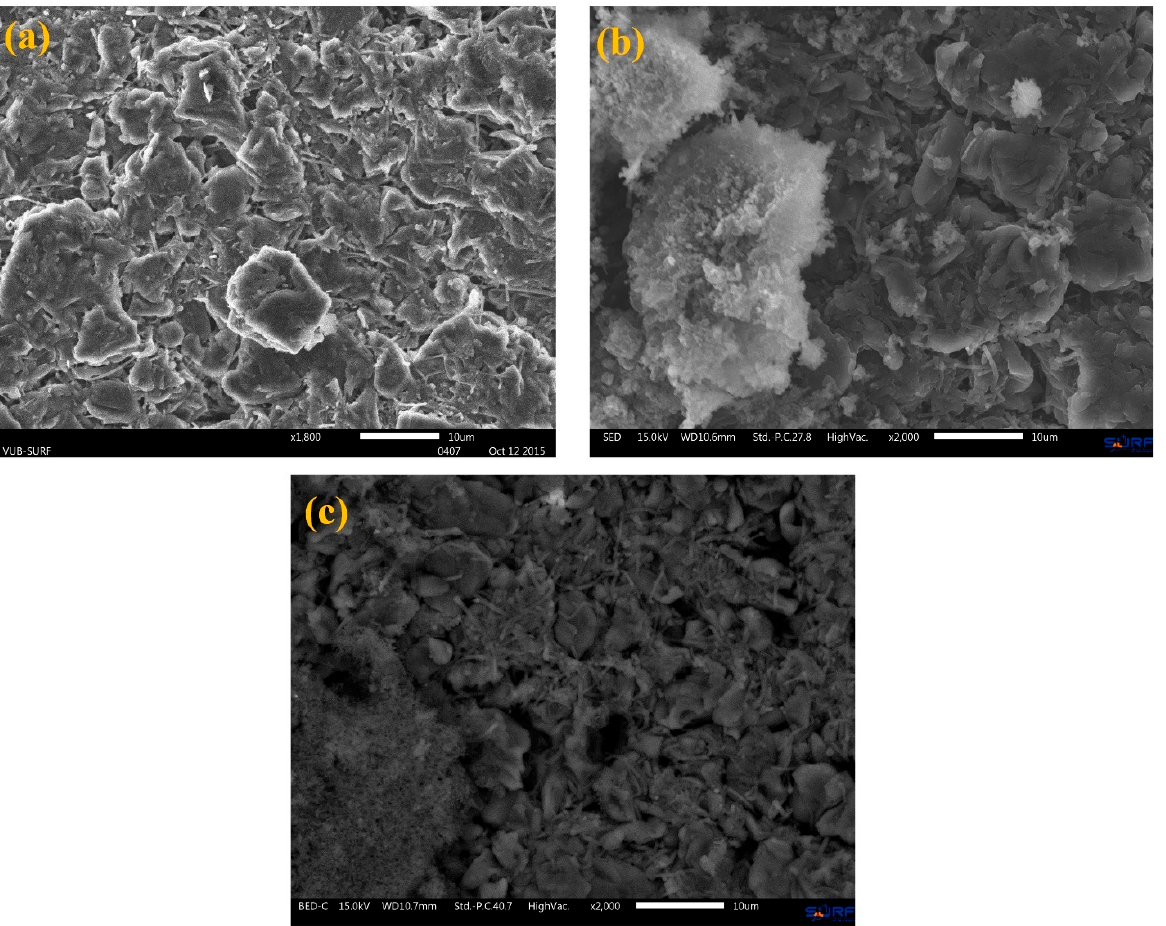
Figure 7. Local SEM images of ( a ) new graphite, ( b ) aged graphite sample, and ( c ) back-scattered image of aged graphite.